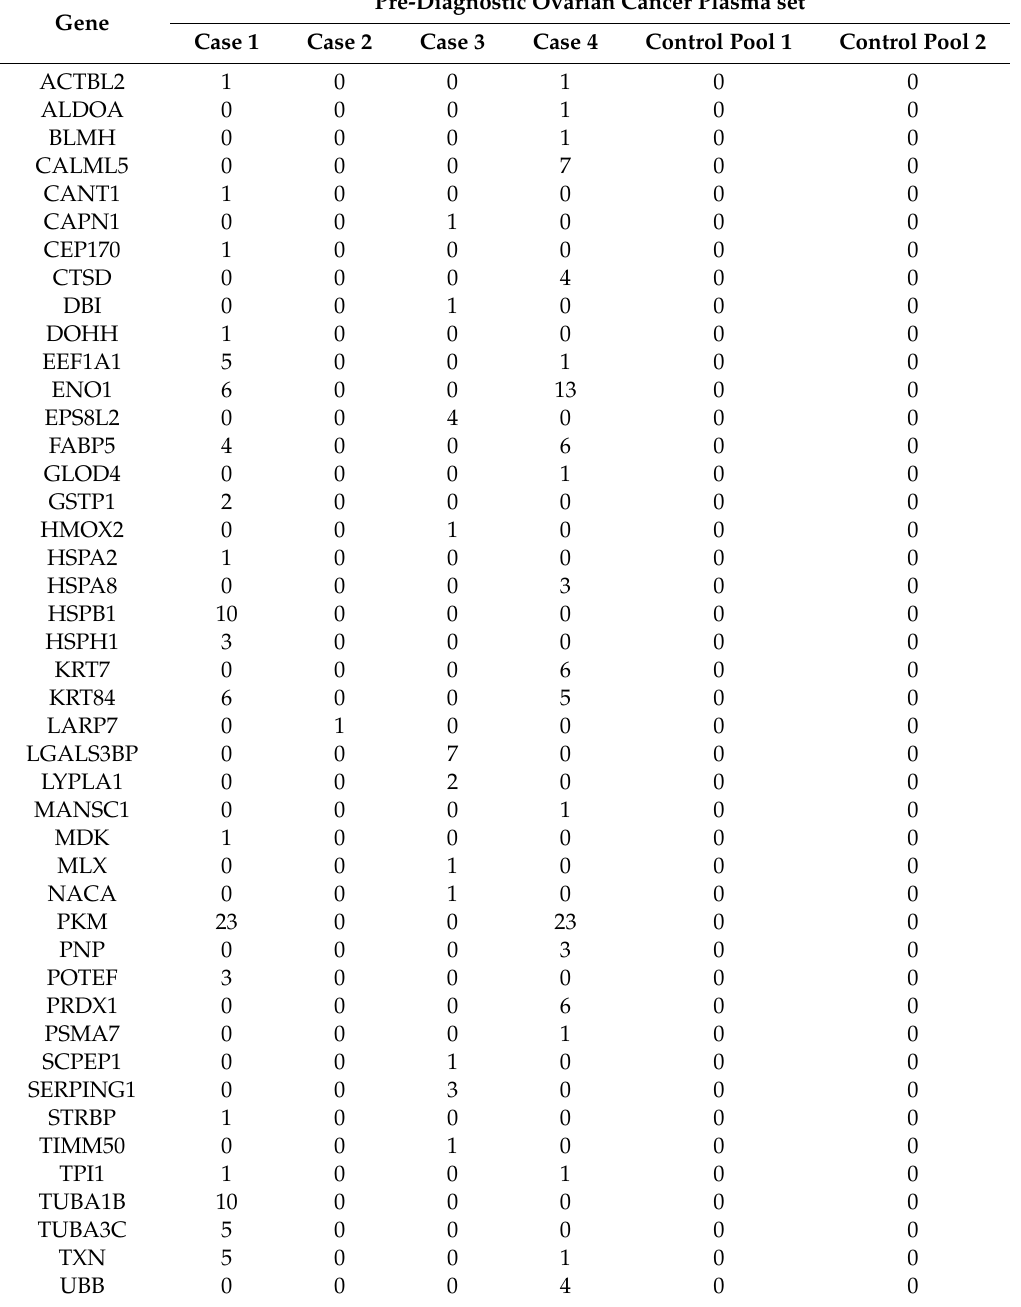
Table 3. Ig-bound proteins in pre-diagnostic ovarian cancer. Number indicates mass spectral counts.